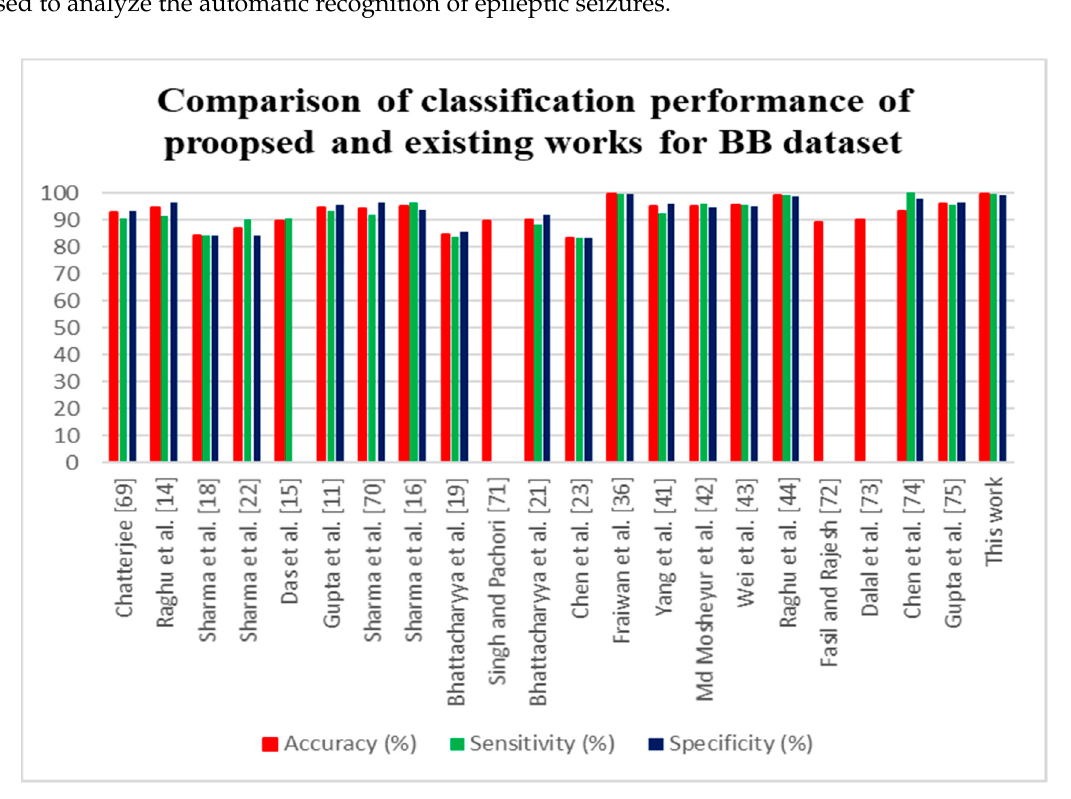
Figure 9. Comparison of classification performance proposed method with existing methods for the BB dataset.